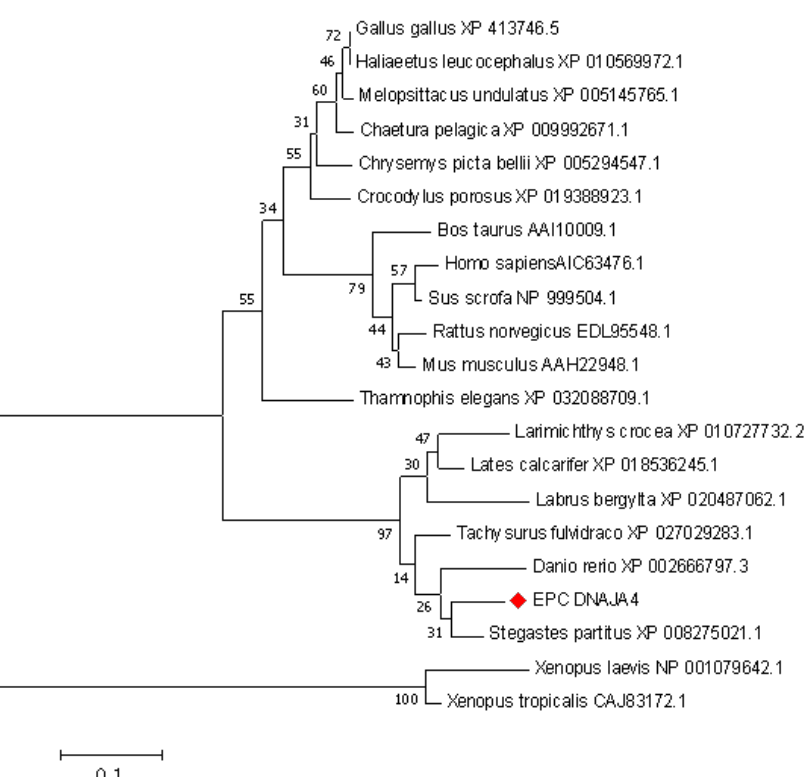
Figure 2. Phylogenetic analysis of DNAJA4 homologs from different species. A phylogenetic tree was constructed based on the protein sequences of DNAJA4-like genes from different species using MEGA 7.0 with the neighbor-joining (NJ) method. Numbers at the nodes denote the bootstrap values of 1000 replicates. Scale represents the numbers of substitutions per 1000 bases.